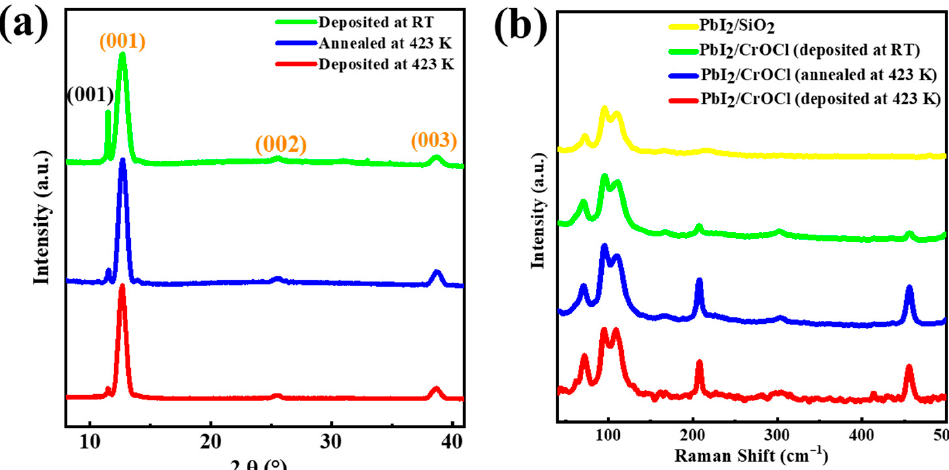
Figure 3. XRD patterns ( a ) and typical Raman spectra ( b ) of PbI 2 /CrOCl heterostructure in three cases.